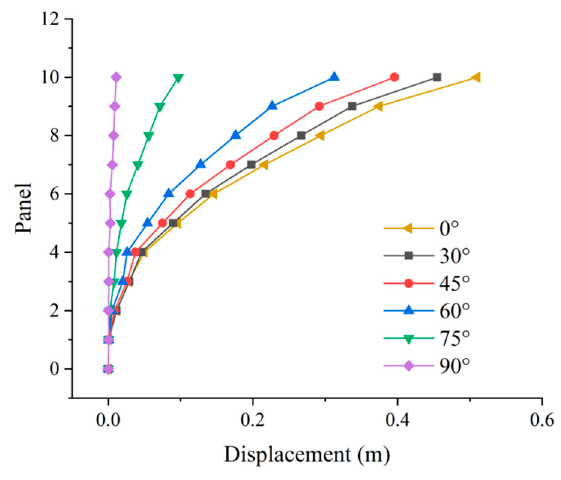
Figure 13. Comparison of displacement of tower top in Y-direction.